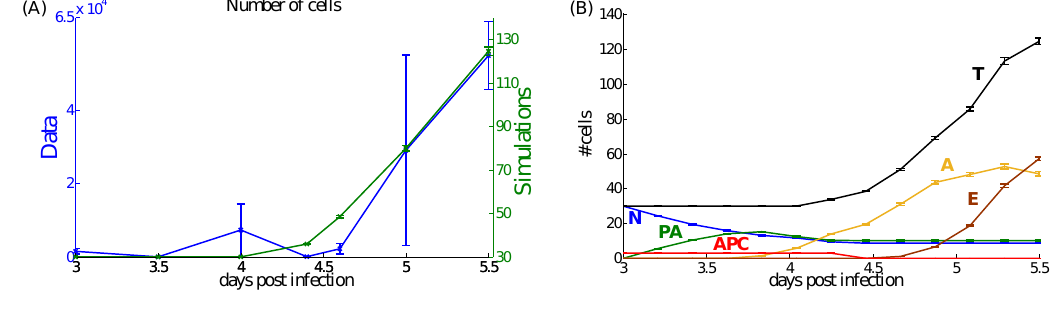
Figure 5. Results at the population level: cell counts. ( A ) Simulation results in green (right y -axis), with the average (of 10 simulations) marked with circles, and experimental results in blue (left y -axis), for the total CD8 T-cell counts. Error bars show the SEM; ( B ) Simulation results present the average (of 10 simulations) and SEM with bars for the total and each CD8 T-cell differentiation stage, as well as APC cell counts. The parameters used for simulations are presented in Tables 3–5. N, Naïve; PA, preactivated; A, activated; E, effector; T, total (N + PA + A +